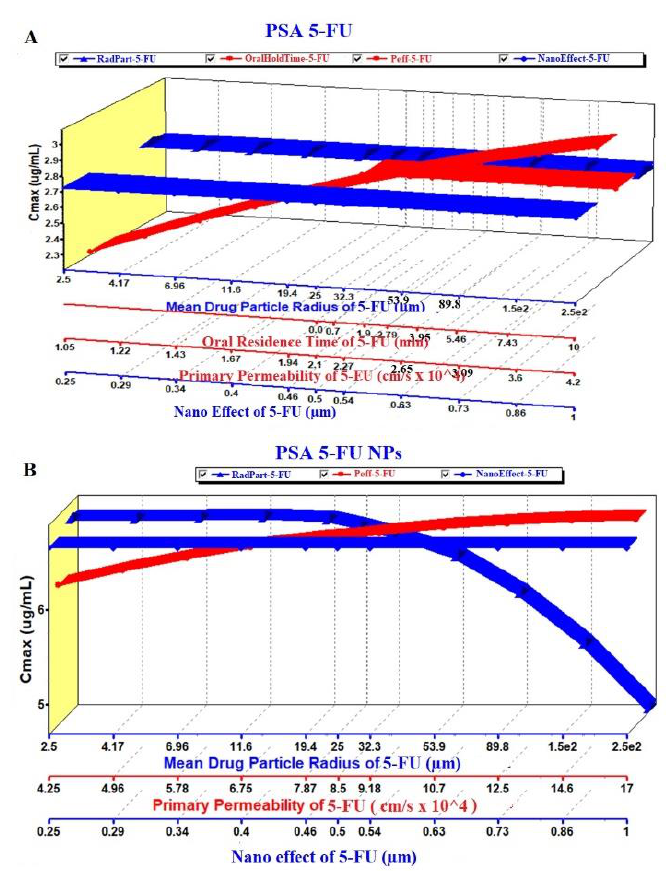
Figure 9. PSA of the pure 5-FU and 5-FU loaded NPs: ( A ) Effect on C max of 5-FU and ( B ) Effect on C max of 5-FU loaded NPs.